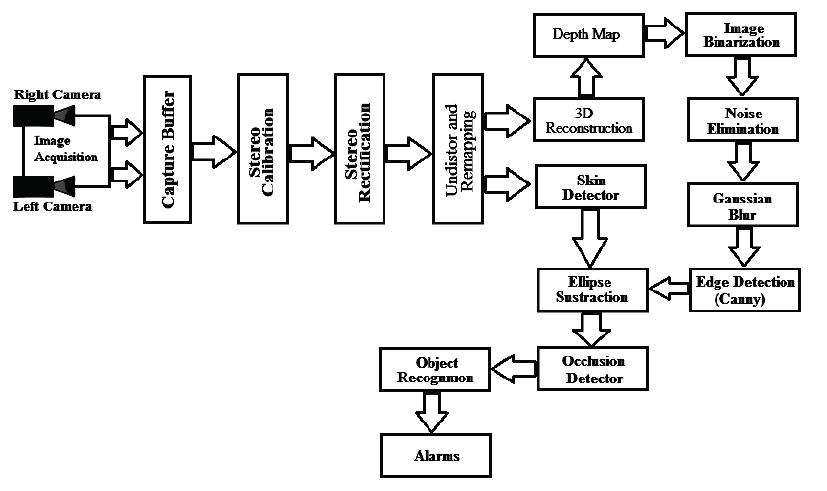
Figure 2. Schematic of vision